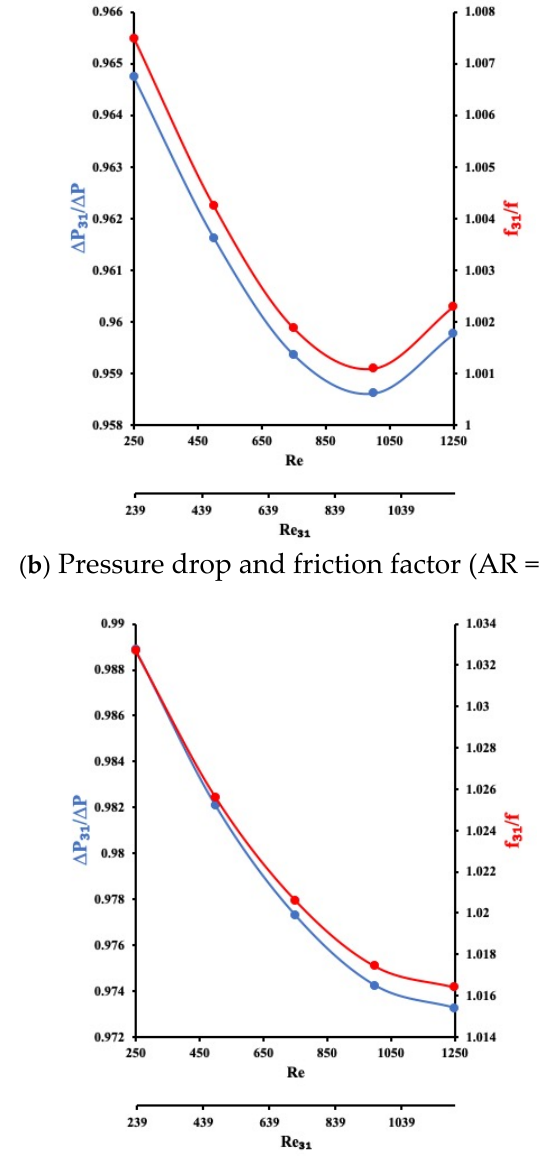
Figure 6. The ratio of the local Nusselt number and performance criterion between nanofluid and water (dp = 31 nm.